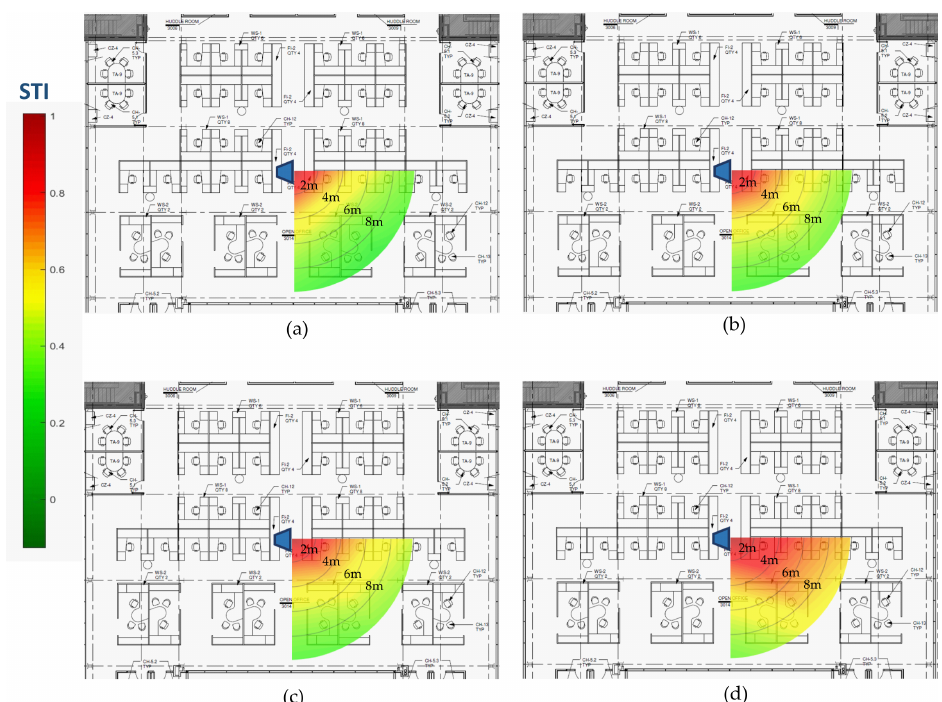
Figure 5. Acoustical comfort visualization through STI surface plots of measurements from the north wing workstation area on the third floor of the building. ( a ) Speaker in sitting position with sound masking on. ( b ) Speaker in sitting position with sound masking off. ( c ) Speaker in standing position with sound masking on. ( d ) Speaker in sitting position with sound masking off. The best- and worst-case scenarios for comfort shown in ( a , d )